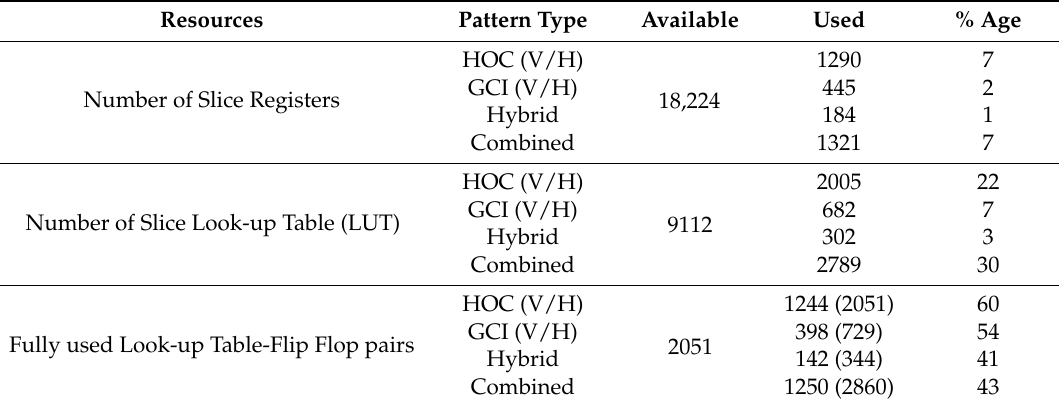
Table 1. FPGA resources required for developing a framework for the individual and multiple types of